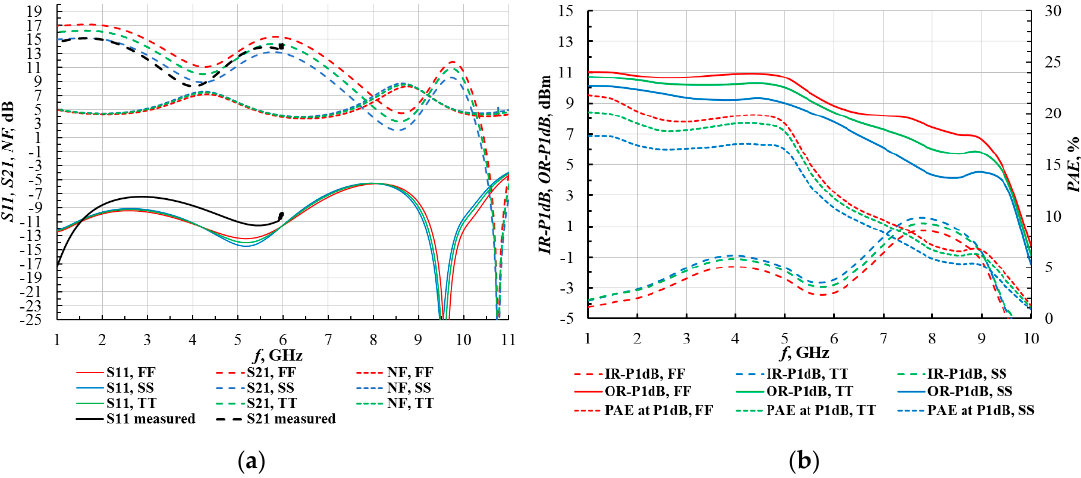
Figure 4. Traveling-wave amplifier chip simulation and measurement results: ( a ) TWA1 with off-chip termination gate SP simulation and measurement results, ( b ) TWA1 with off-chip gate termination HB simulation results.